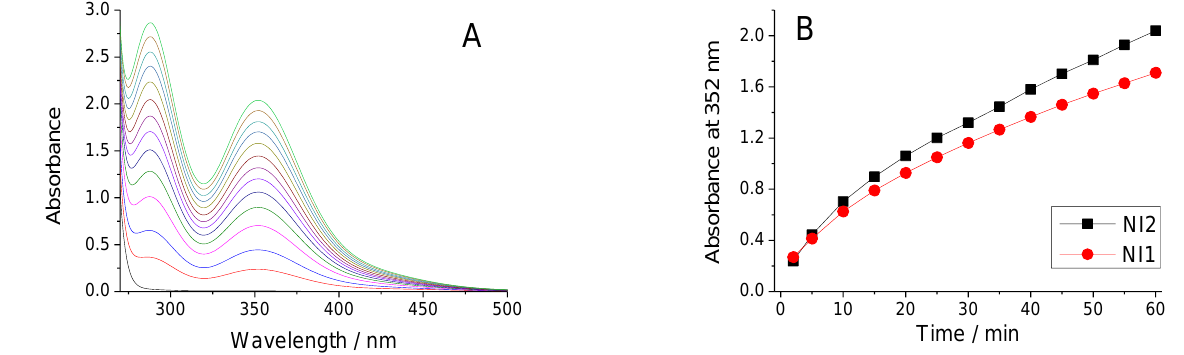
Figure 4. ( A ) Absorption spectra of KI in the presence of 1 cm 2 cotton fabric dyed with NI1 as a function of irradiation time; ( B ) dependence of absorbance at 352 nm, corresponding to I 3 − caused by irradiation of dyed cotton fabric with NI1 and NI2.